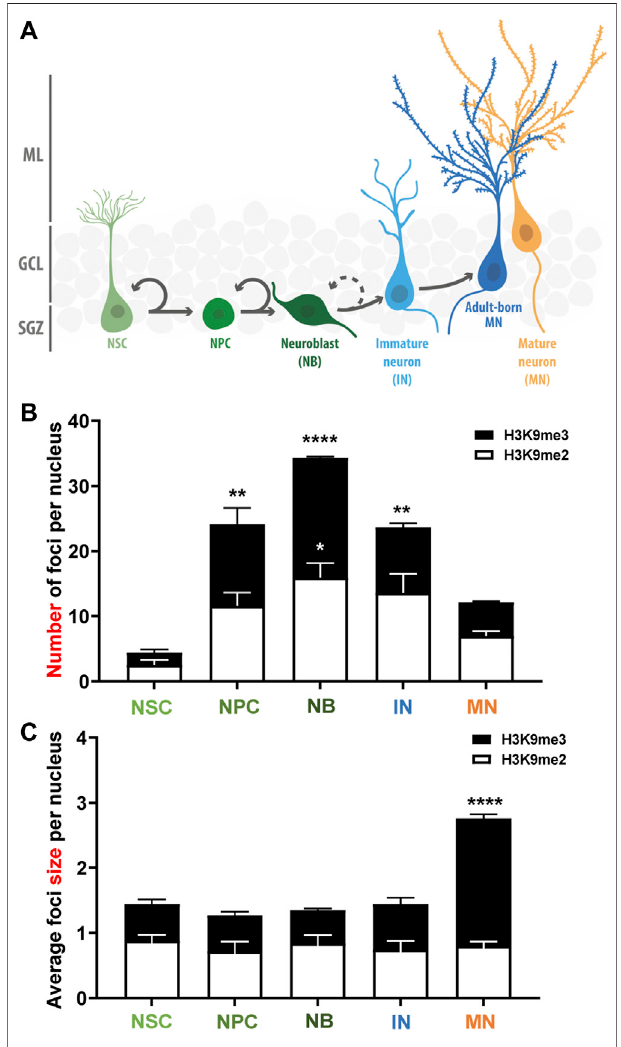
FIGURE 3 | Changes in the number and size of H3K9me2/me3 foci during the stages of adult neurogenesis in the mouse hippocampus. (A) Schematic representation of the adult neurogenesis process in the adult mouse dentate gyrus. Neural stem cells (NSC) proliferate asymmetrically togenerateneuralprogenitorcells(NPC)thatgiverisetoneuroblasts(NB)that differentiate morphologically into immature granule neurons (IN) that became matureneurons(adultbornMN).Inouranalyses,H3K9me2/me3stainingwas analyzed in NSC, NPC, NB and IN, and in mature neurons of the outer third of the GCL (MN) which are MN generated during embryonic development. (B,C) Average number ofH3K9me2 (white bars) and H3K9me3 (black bars) foci per nucleus (B) andfocisize (C) inthedifferentcell-typesduringtheprogressionof neurogenesis. Bars show mean ± SEM. Statistical differences compared to the NSCs are indicated. * p < 0.05; ** p < 0.01, **** p < 0.0001, one-way ANOVA followed by Bonferroni posthoc test, N (cid:1) 3 mice. SGZ: Subgranular zone; GCL: Granule cell layer; ML: Molecular